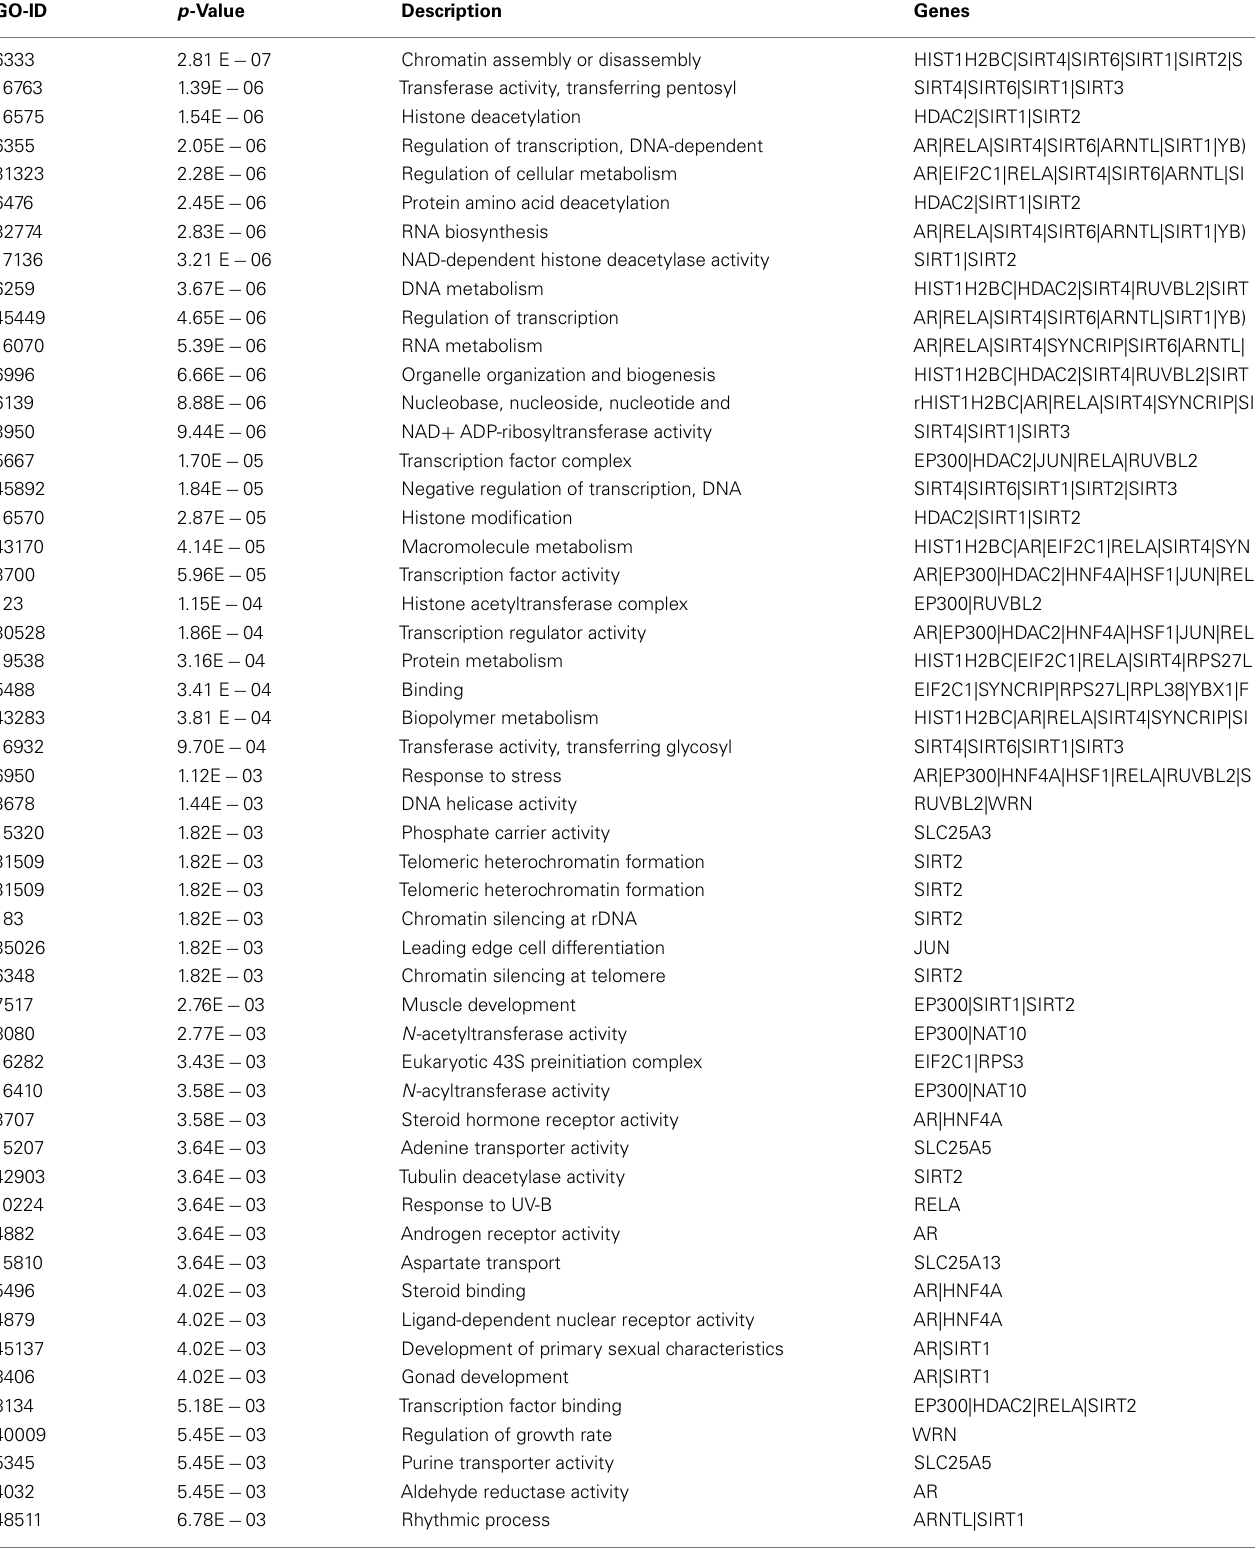
TableA2 | Biological processes associated with interacting proteins in the Sirt 1 interaction maps with significant p -value.